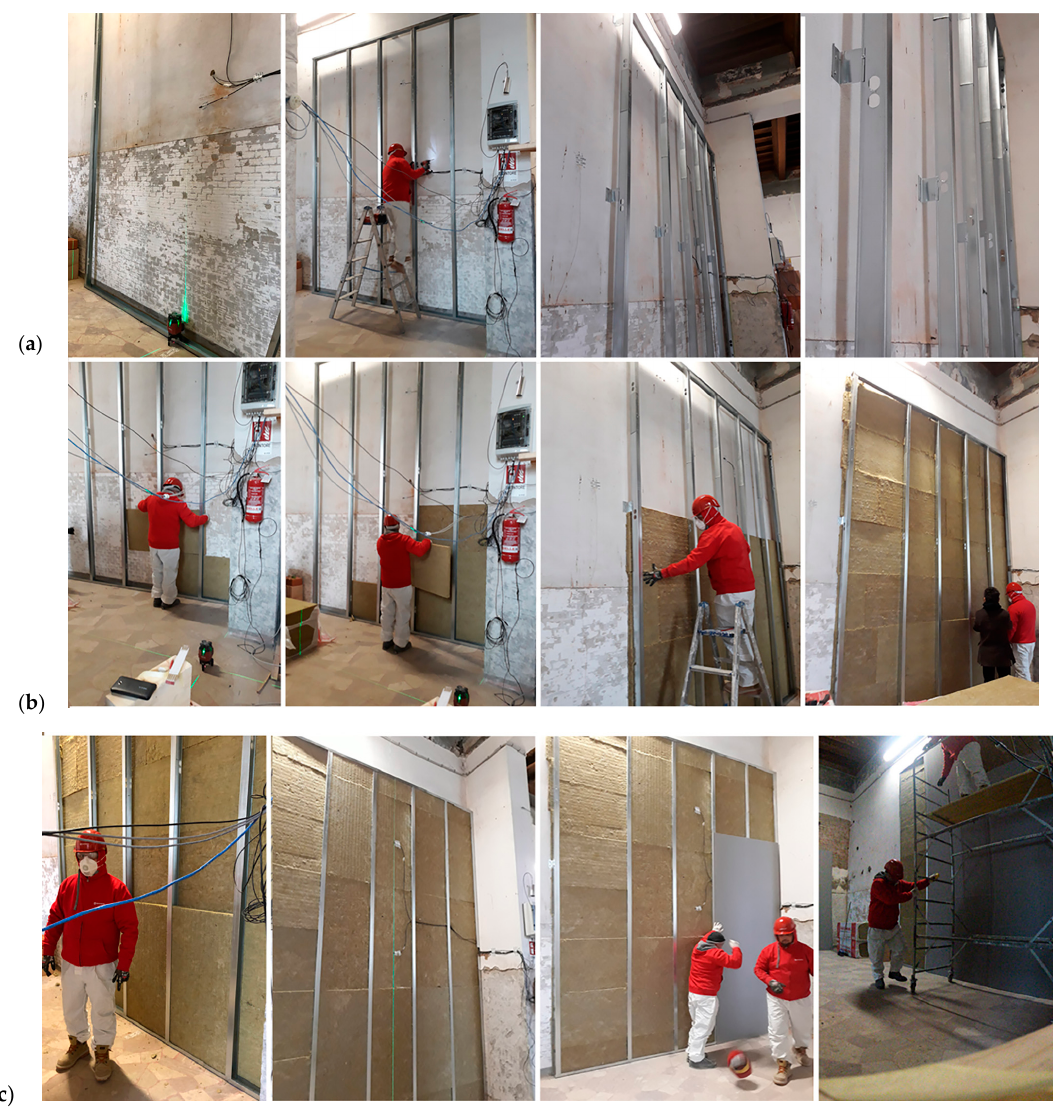
Figure 4. Installation of the selected insulation system.